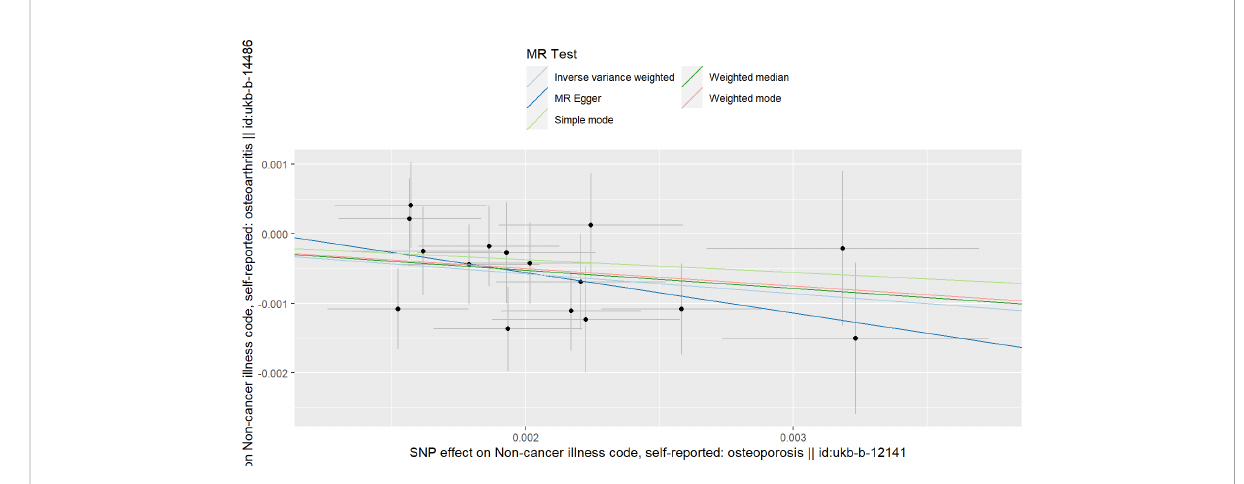
FIGURE 3 Scatterplots of the causal relationships between osteoporosis and hip